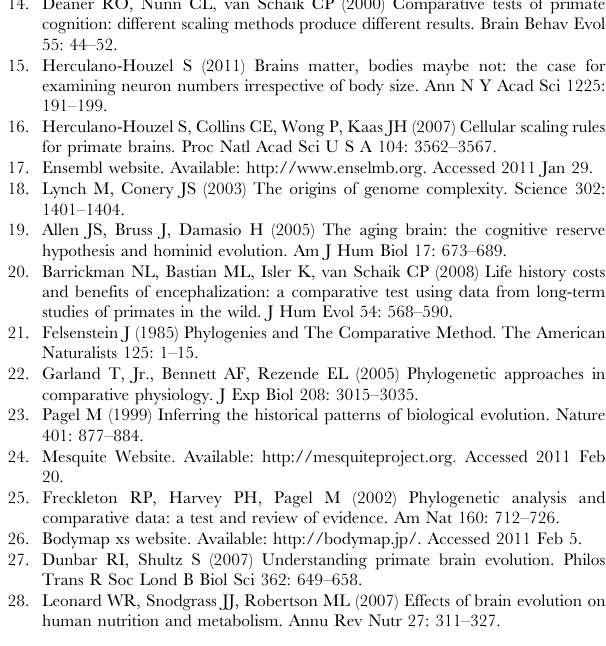
Figure S2 Lack of correlation between DNA nucleotide content and encephalization. Graph showing linear regres- sion between Ei and mean percentage G + C content of protein- encoding sequences (including introns) per species. G + C contents for all species were obtained from Ensemble data resources.